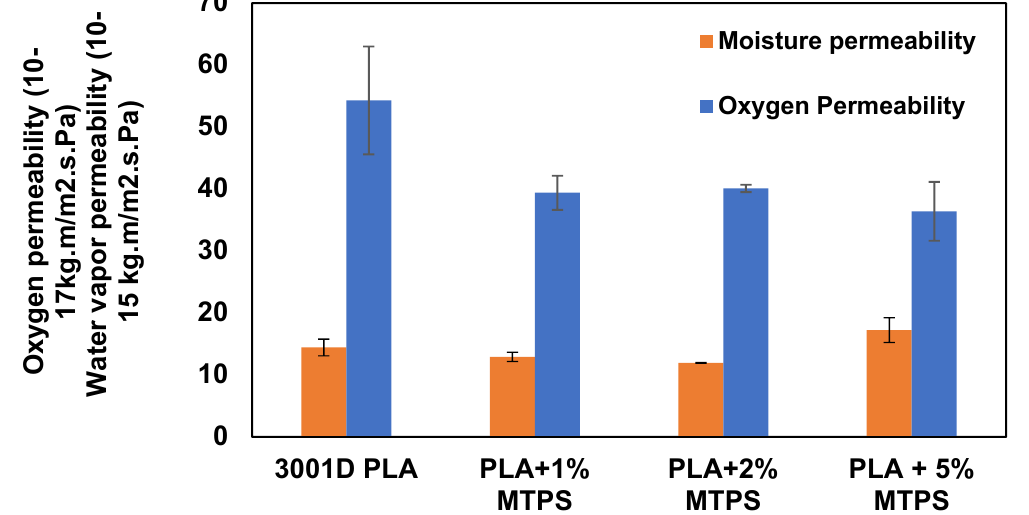
Figure 16. Effect of MTPS content on moisture permeability (WVP) and oxygen permeability (OP) of PLA films.